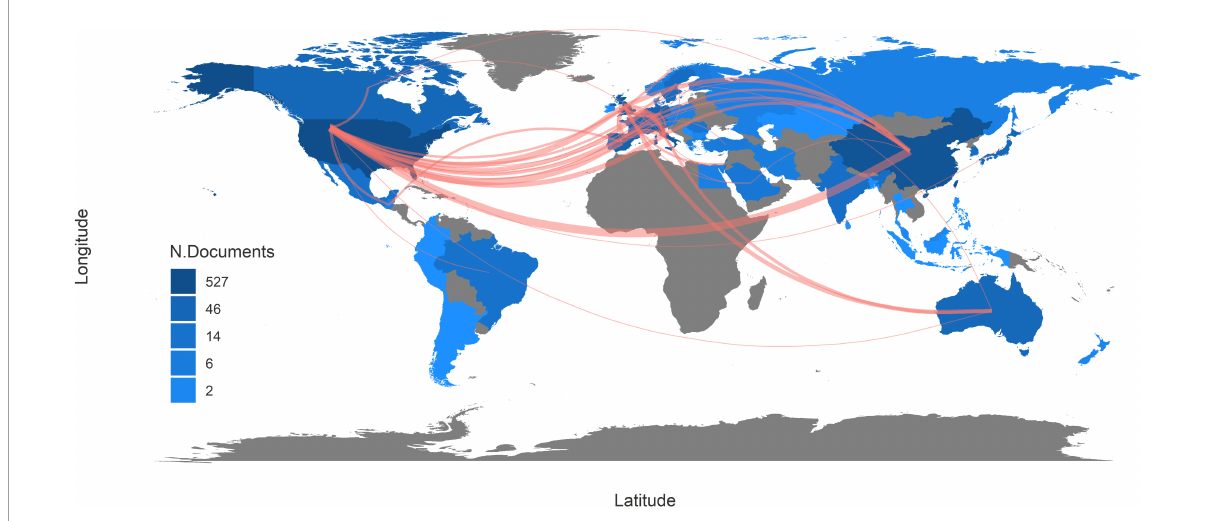
FIGURE3 Country collaboration map. The red line indicates that there was collaboration between two countries. The more connections two countries have, the thicker the line is. The deeper the color of a country is, the more documents are published in this